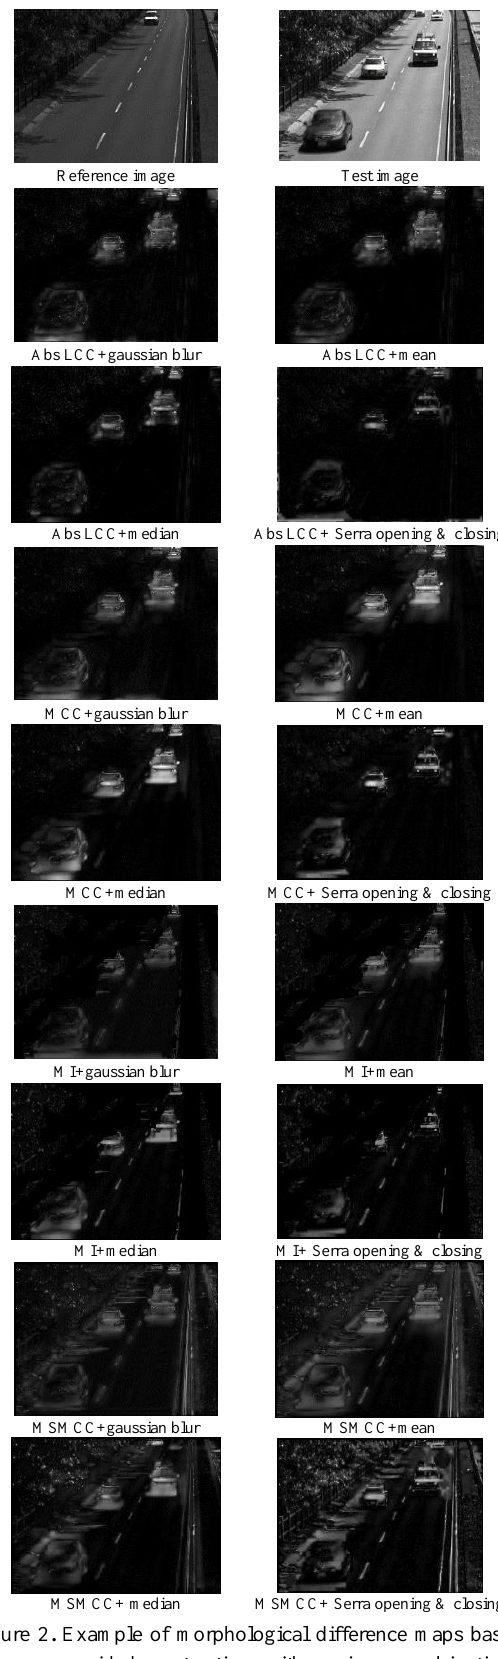
Figure 2 . Example of morphological difference maps based on guided contrasting with various combinations of LSC and SO (outdoor video